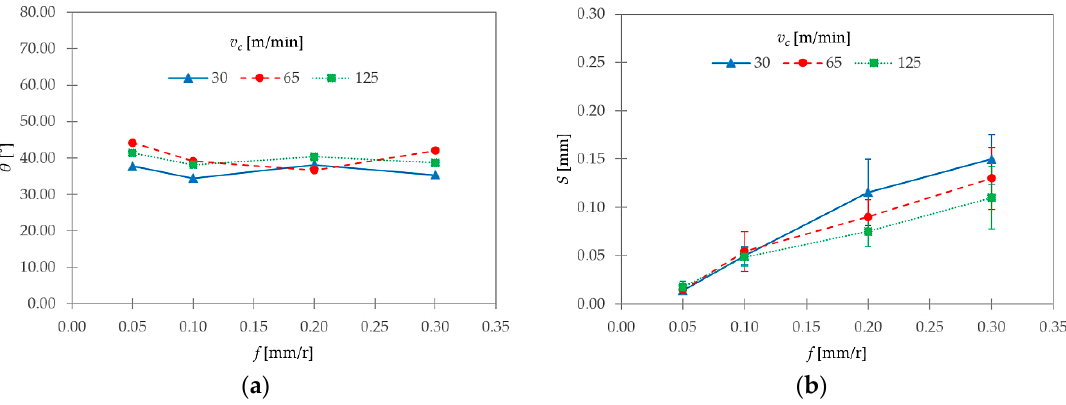
Figure 13. ( a ) Shear angle ( θ ) and ( b ) segment width ( S ) as a function of v c and f .